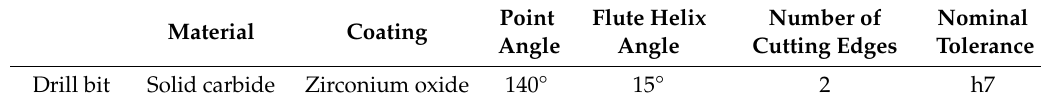
Table 1. Drill bits